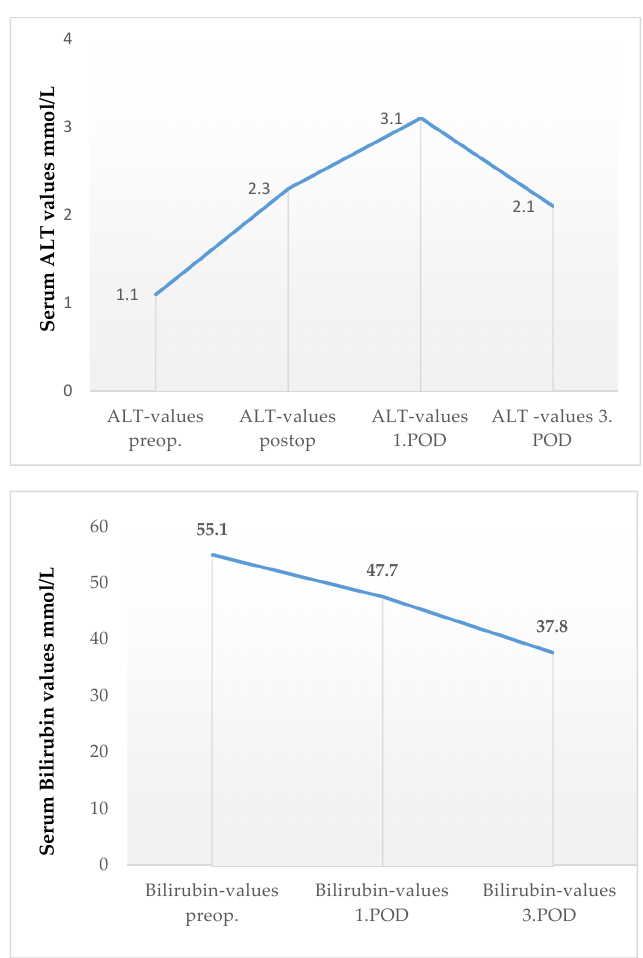
Figure 4. Course of postoperative bilirubin and Alanin Aminotransferase (ALT) values. Entries are means; preop.: preoperative; postop.: postoperative (2 hours after the operation); POD: postoperative day.